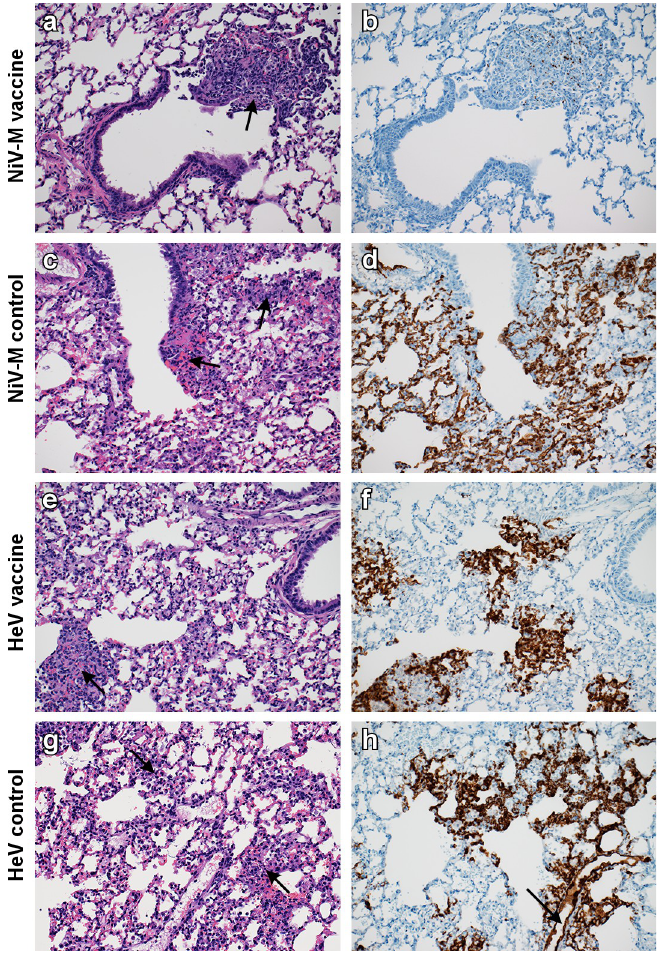
NiV B or injected with ChAdOx1 FGP and challenged with NiV Malaysia or HeV. Lung tissue was collected at D4 (HeV) or D5 (NiV). Tissue sections were stained with hematoxylin-eosin (left panels) or with target-specific probes for viral RNA, which is visible as a red-brown staining (right panels). (a-b) Lung tissue obtained at D5 of animals vaccinated with a single-dose of ChAdOx1 NiV B and challenged with NiV Malaysia. (c-d) Lung tissue obtained at D5 of animals injected with a single-dose of ChAdOx1 FGP and challenged with NiV Malaysia. (e-f) Lung tissue obtained at D5 of animals vaccinated with a single-dose of ChAdOx1 NiV B and challenged with HeV. (g-h) Lung tissue obtained at D5 of animals injected with a single-dose of ChAdOx1 FGP and challenged with HeV. Arrow in H&E = Inflammatory cells, fibrin, edema and hemorrhage centered on terminal bronchioles. Arrow in ISH = Positive endothelial cells lining an artery. 200x magnification. H&E and ISH slides were from sequential